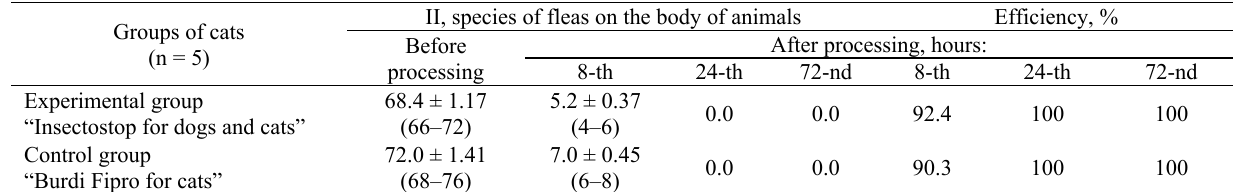
Efficiency of the drug “Insectostop for dogs and cats” and the reference drug “Bourdi Fipro for cats” for cat Siphonapterosis (M ± m) II, species of fleas on the body of animals Groups of cats Experimental group “Insectostop for dogs and